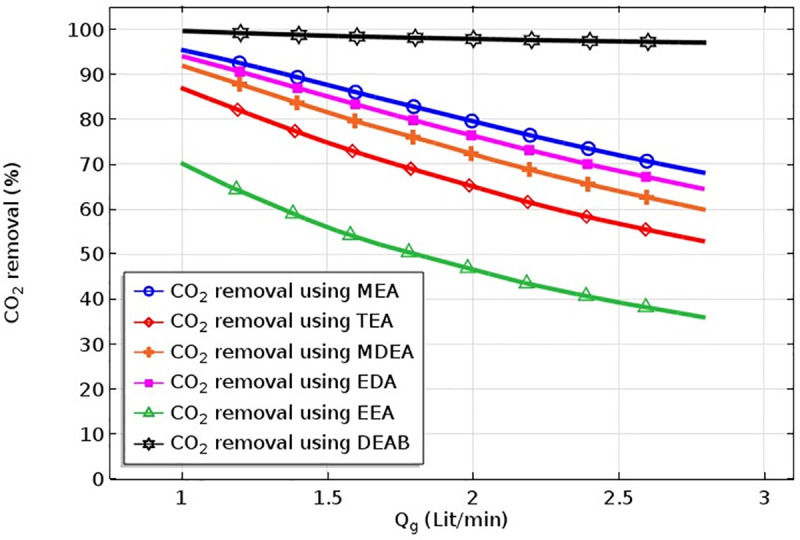
Effect of gas flow rate on the CO2 removal using MEA, TEA, EEA, EDA, MDEA and DEAB absorbents.